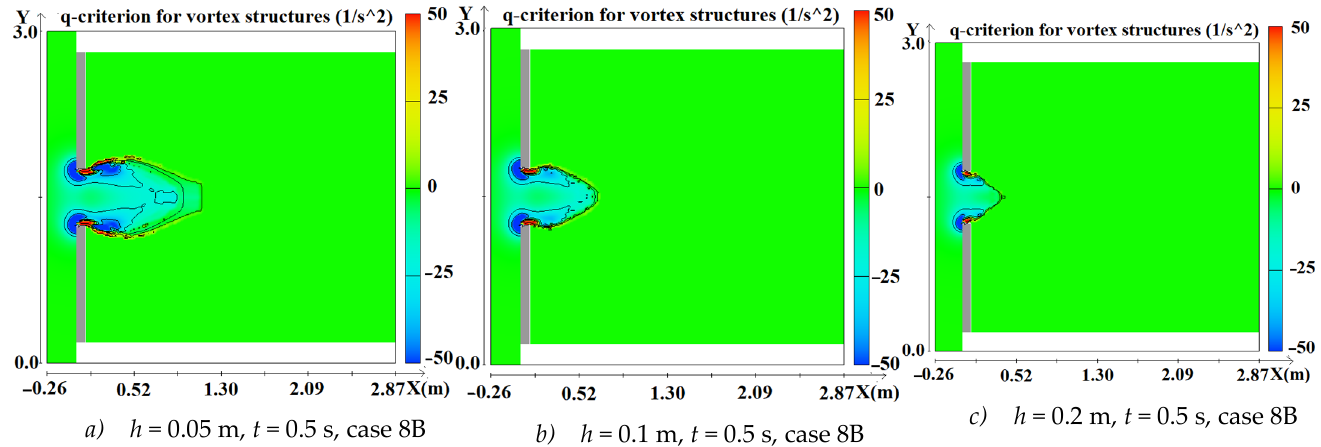
Figure 15. Contour maps of q – criterion at t = 0.5 s at different water depths.